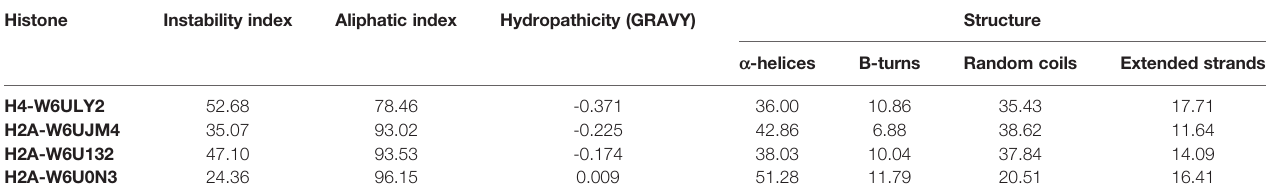
TABLE 4 | Physicochemical parameters and secondary structure of the histones identi fi ed.